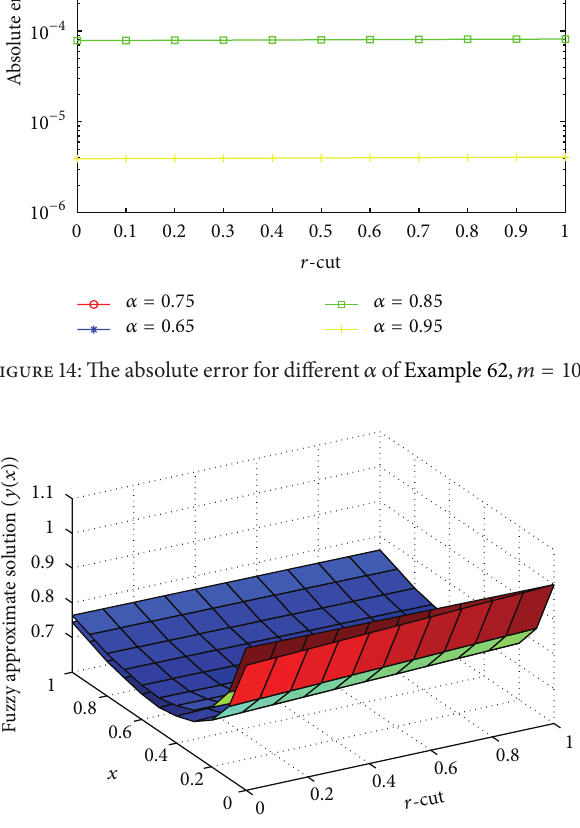
Figure 15: The fuzzy approximate solution of Example 62, 𝛼 = 0.75, 𝑚 = 10 .